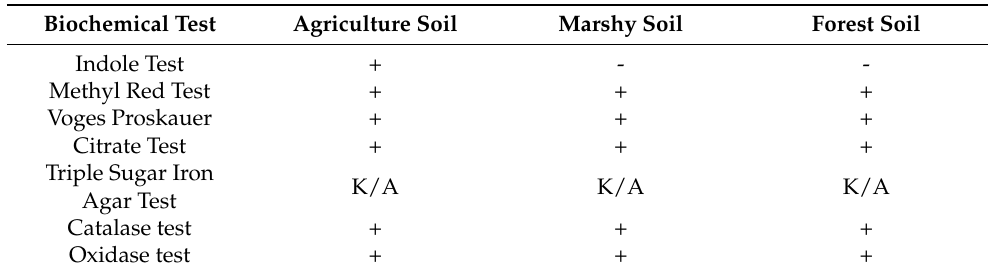
Table 2. Biochemical Characterization of bacterial isolates from Agricultural, Marshy, and Forest soil collected from Khyber Pakhtunkhwa,